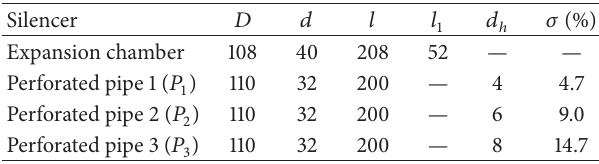
pipe silencers with the help of perforate impedance models. Table 1: Dimensions for the silencers considered (unit: